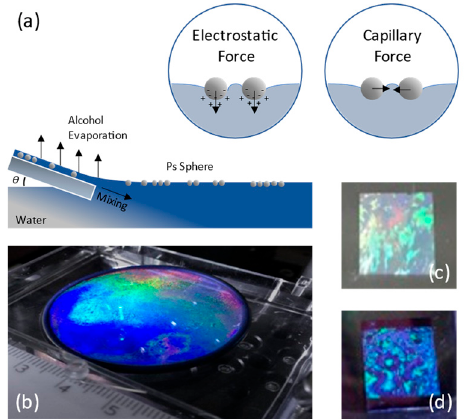
Figure 1. ( a ) Schematic illustration of the CPA monolayer formation on the water surface driven by a specific combination of electrostatic and capillary forces; ( b ) photograph of the close-packed self- assembled monolayer at air/water interface confined within the large area of the ring; photograph of a sample after the transfer of the colloidal mask onto glass ( c ) and silicon ( d ) substrates .